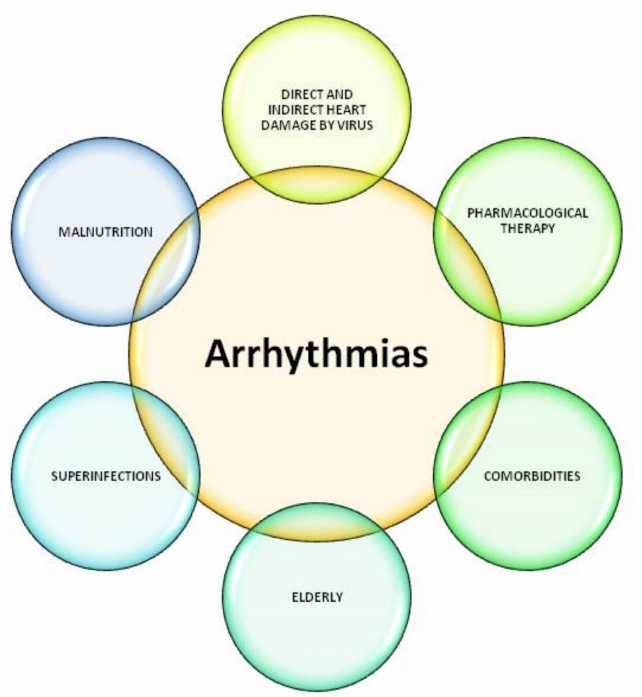
Figure 2. The main modifiable and non-modifiable risk factors that may predispose patients to ar- rhythmias. Several arrhythmias may arise in patients with myocarditis during SARS CoV-2 infection, especially in the critical care setting. Among them, both bradyarrhythmias (such as atrioventricular nodal block, sinus node dysfunction, and sinus bradycardia) and tachyarrhythmias (such as ven- tricular tachycardia, atrial fibrillation, atrial flutter, atrial tachycardia, sinus tachycardia) may occur. Inflammatory cytokines acting on both cardiomyocytes (especially interleukin 6) and autonomic ner- vous system (ANS) can promote QTc prolongation. The administration of antivirals (such as protease inhibitors lopinavir/ritonavir), antibiotics (such as macrolides, fluoroquinolones, and others), and the antimalarials (such as hydroxychloroquine) can trigger similar consequences. Finally, cardiometabolic risk factors (such as obesity, diabetes), recent or existing cardiac diseases (previous myocardial injury, atrial fibrillation, hypertensive heart disease, and others), and chronic pneumopathies (chronic ob- structive pulmonary disease (COPD) and others) are examples of the comorbidities that increase the risk of heart damage and therefore favor the onset of malignant